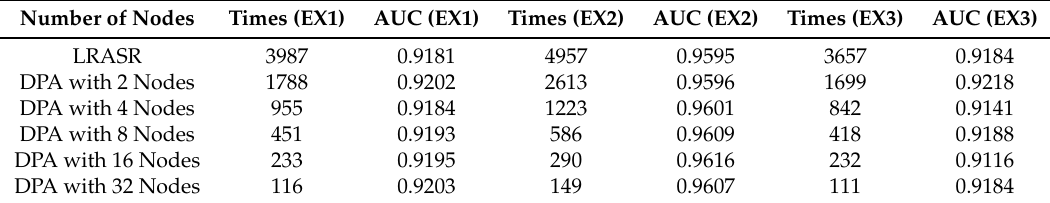
Table 2. AUCs and Consumed Times(s) obtained by LRASR and DPA with different numbers of nodes in Experiments 1–3.